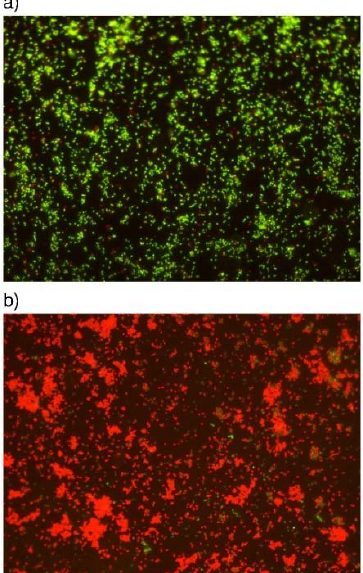
Figure 5. Dual fluorescent staining analysis for vital (Green) and dead (Red) bacterial cells on ( a ) uncoated and ( b ) Ag ‐ DLC coated Ti6Al4V substrates . Reprinted/adapted with permission from Ref. [49]. Copyright 2011, Elsevier.